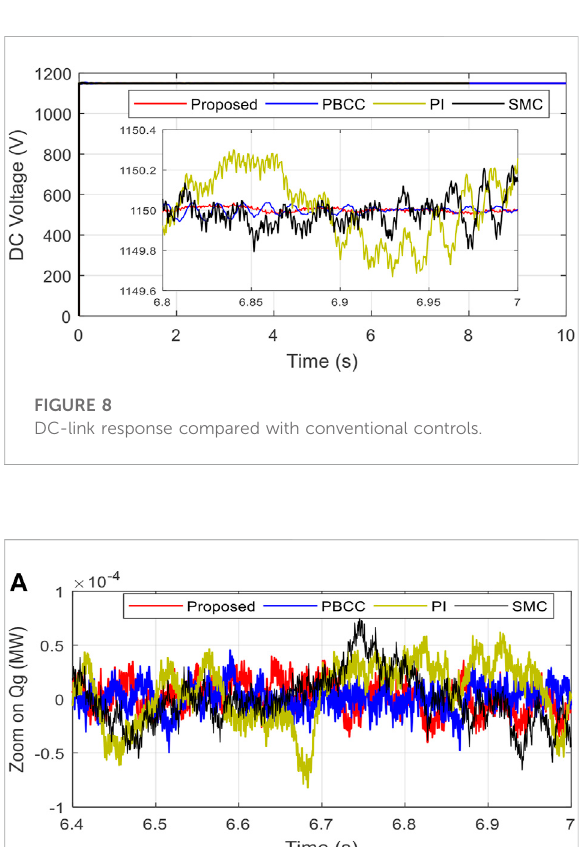
FIGURE 6 Wind speed.